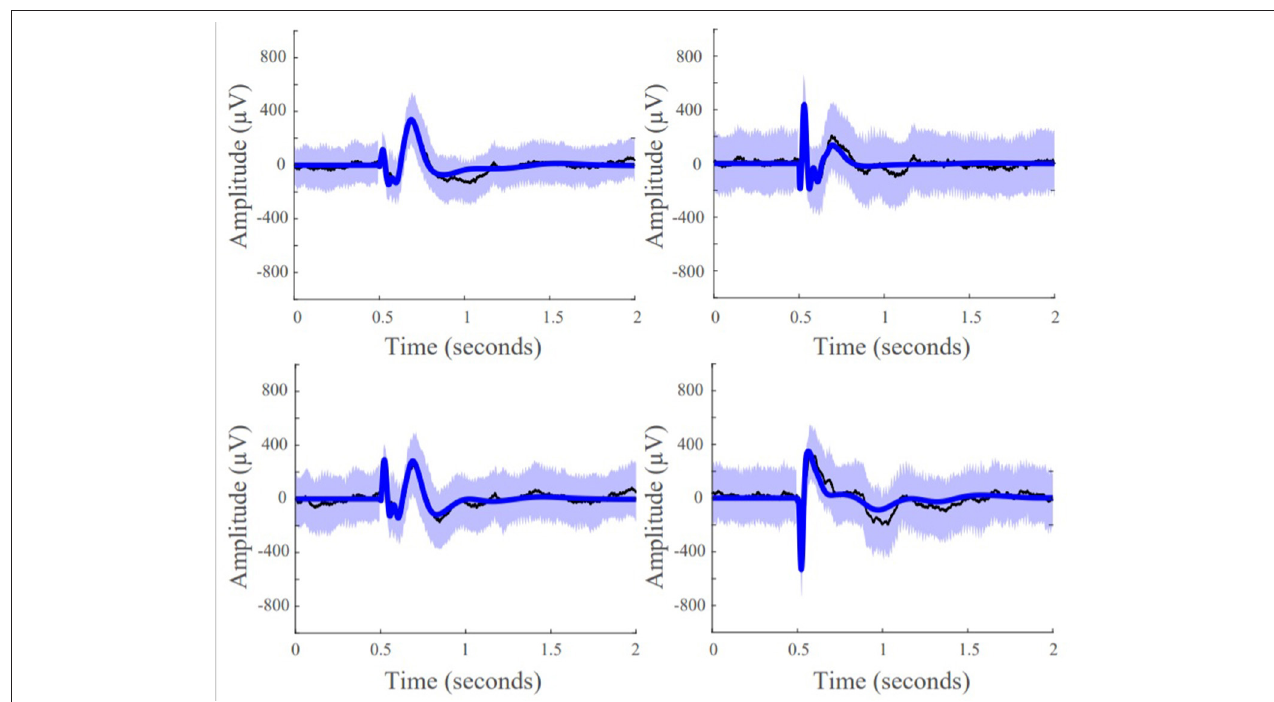
FIGURE 5 | Model fits of four representative responsive channels from patient data showing SIMO transfer function models capture CCEP responses in recording electrodes. Black lines are the average the evoked responses, blue lines are the model reconstruction, and the purple boundaries denotes one standard deviation.